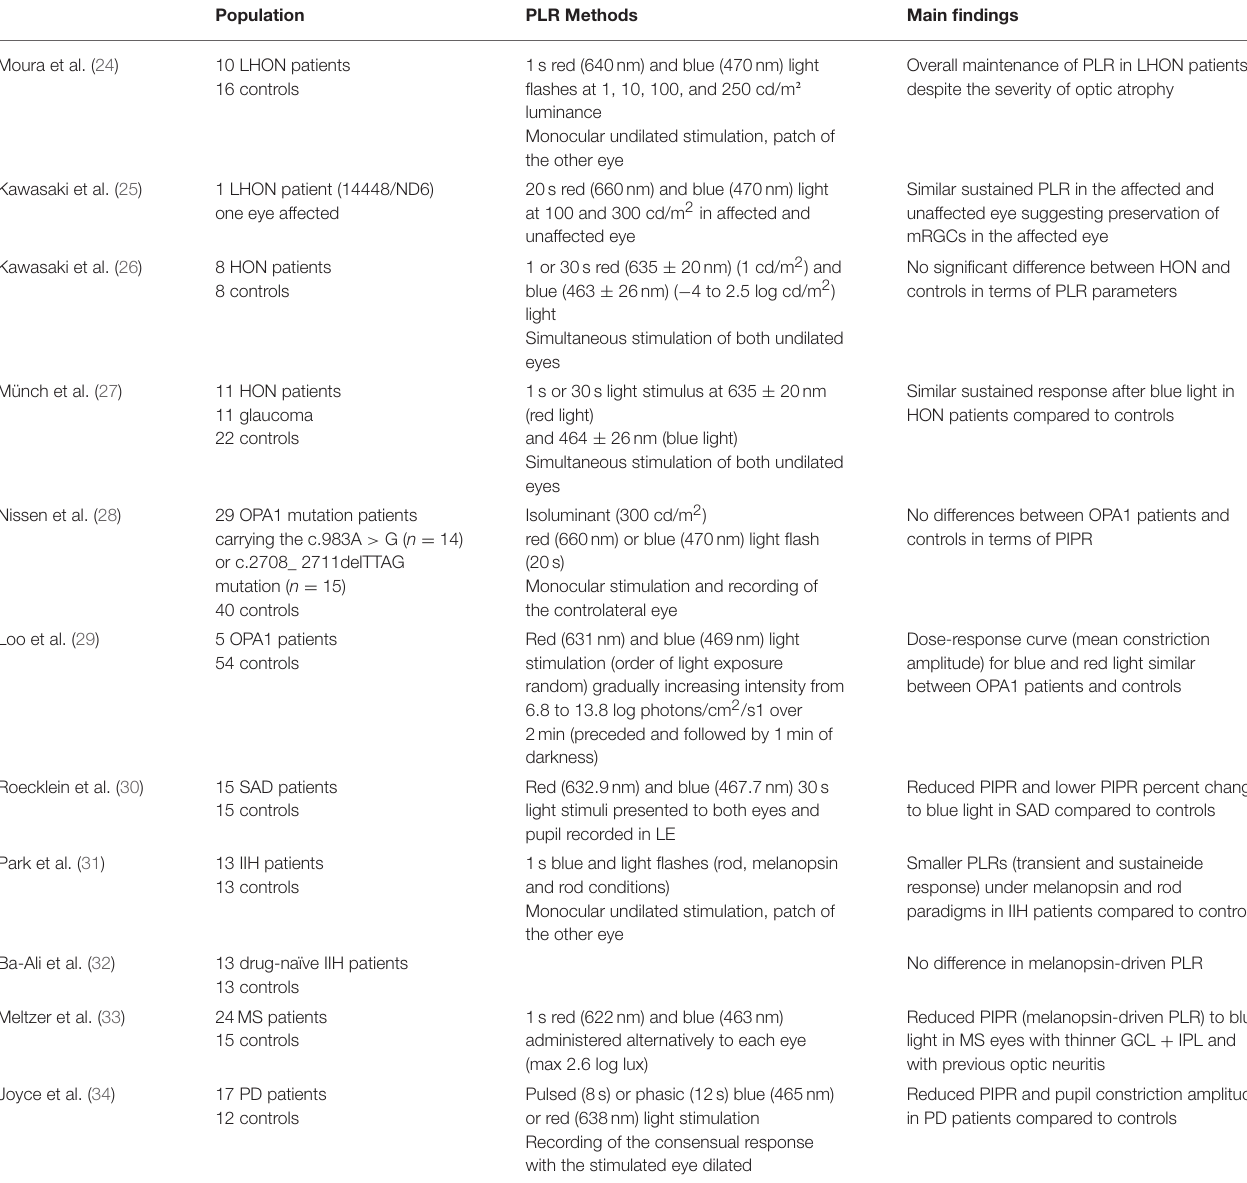
TABLE 2 | Pupillometry findings in neurological